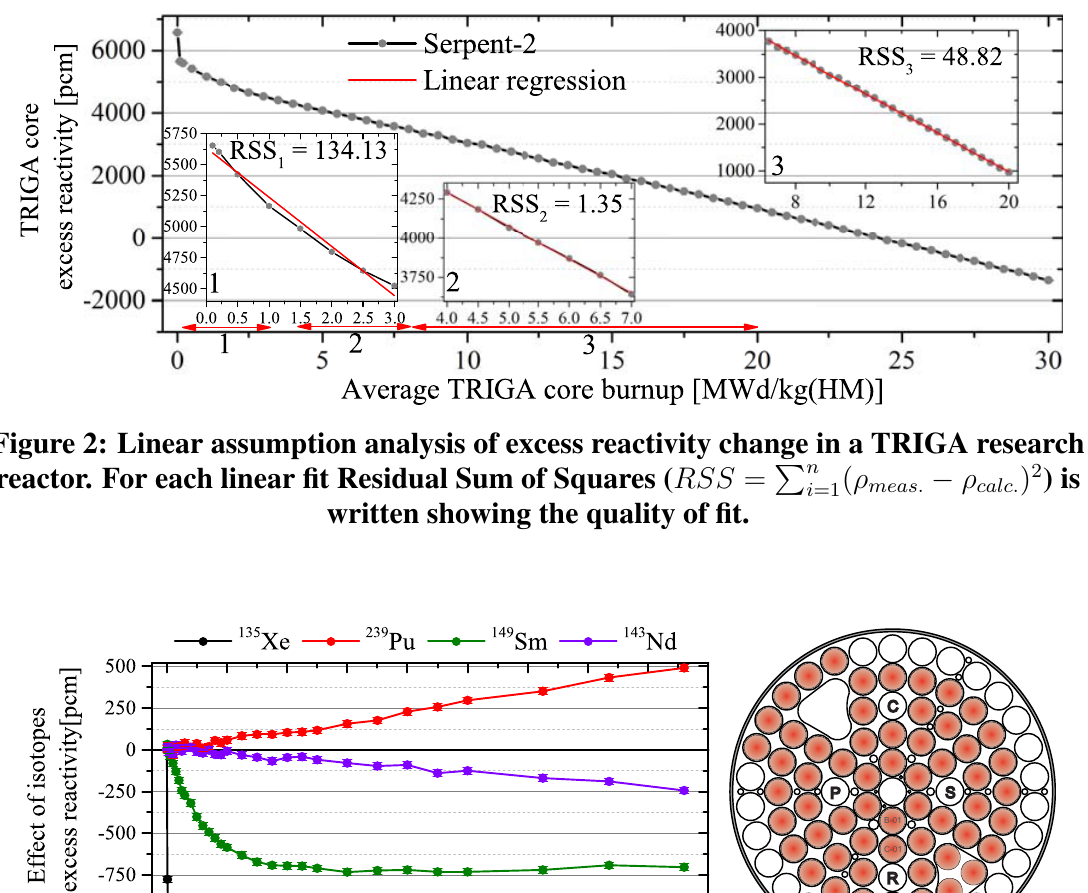
Figure 3: Effect of four important isotopes on reactor core reactivity at different average core burnups (left). Core schematic used in the analysis is depicted on the